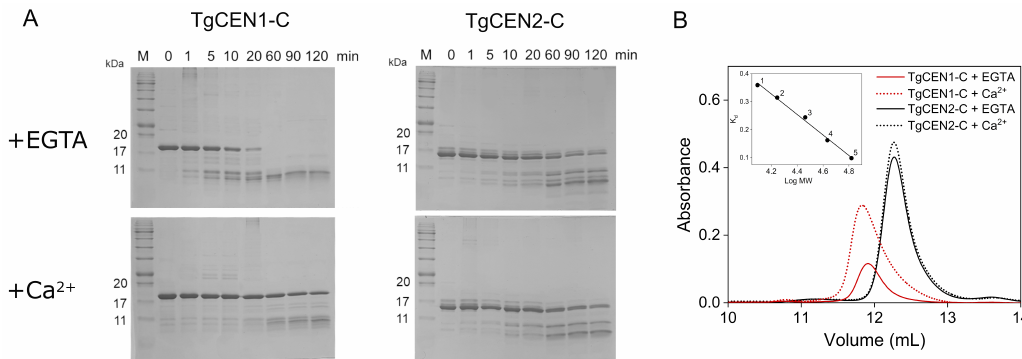
Figure 4. Representative tryptic digestions ( A ) and SEC profiles ( B ) of TgCEN1-C and TgCEN2-C in the presence of EGTA or CaCl 2 . ( A ) Tryptic digestion: the intensity of the untreated centrin band in lane 2 was assumed to be 100%. Lane 1: MW marker, lanes 2–9: trypsin digestion products obtained following incubation of protein with trypsin 1:500 w / w for 0, 1, 5, 10, 20, 60, 90 and 120 min, respectively. ( B ) SEC profiles: proteins were analyzed at 2 mg / mL on a Superdex 75 Increase 10 / 300 GL gel filtration column in bu ff er containing EGTA (5 mM; solid trace) or CaCl 2 (5 mM; dotted trace). Inset , calibration curve of distribution coe ffi cient K d versus the logarithm of the molecular weight. The standard proteins used were: 1, cytochrome c; 2, myoglobin; 3, carbonic anhydrase; 4, ovalbumin; 5, albumin bovine